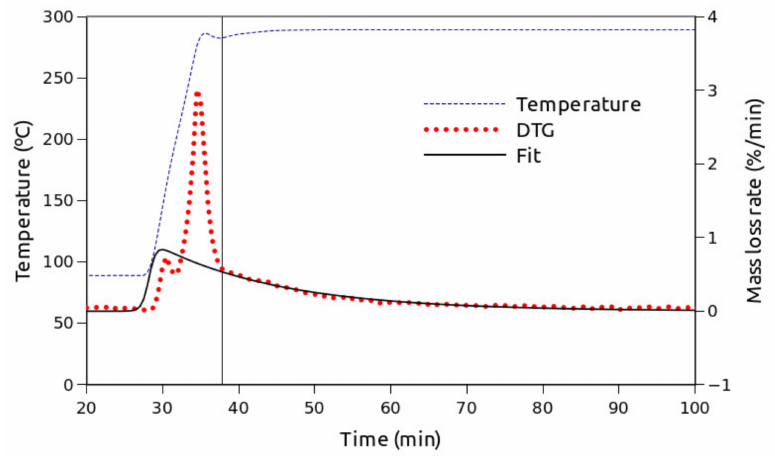
Figure 3. Plot of the fitting of a DTG curve by a time derivative generalized logistic function.